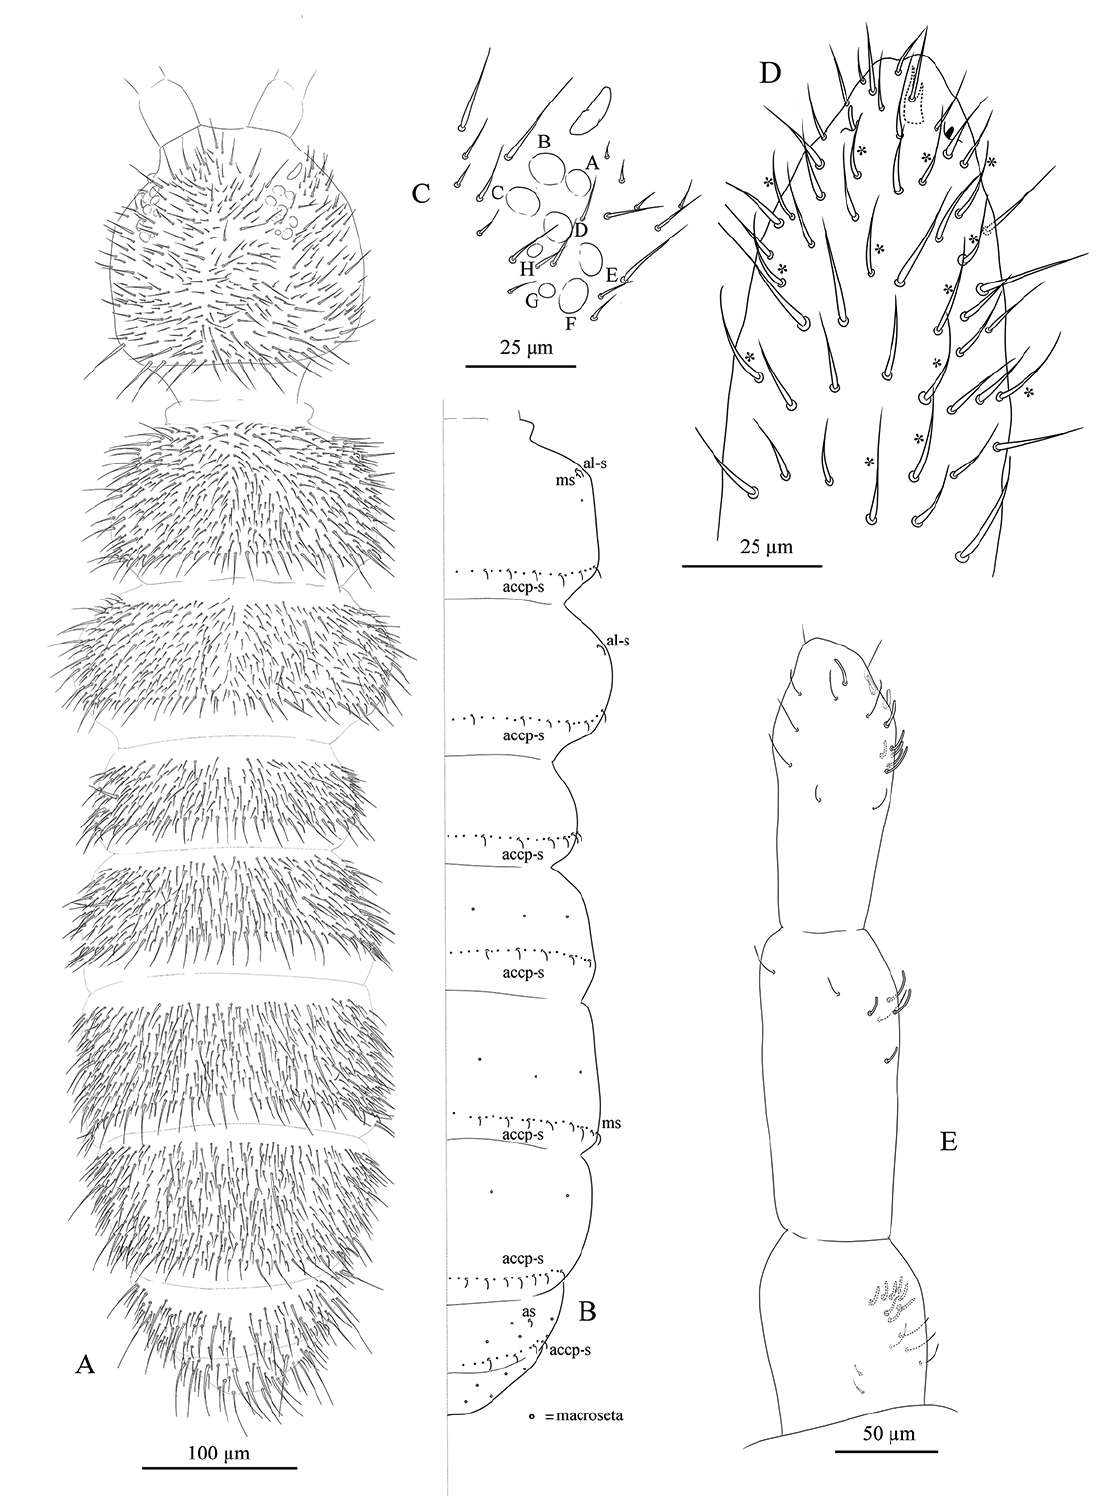
Fig. 2. Desoria calderonis sp. nov . A . Dorsal chaetotaxy. B . Number and distribution of dorsal s -setae (accp-s: accp -setae; al-s: al -setae; as: as -setae) and ms -setae (ms). C . Ocular plate (A–H: eyes) and PAO. D . Ant. IV apical dorsal part; asterisk = seta-like s -seta. E . Ant. I–III, dorsal view, with s -setae (double line) and seta-like s -setae (simple line); on ventro-proximal part of Ant. I, two isolated microsetae